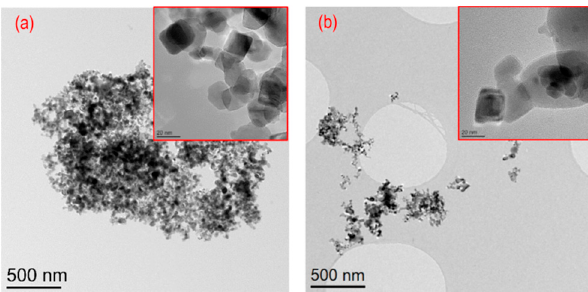
Figure 1. TEM images of ( a ) TiO 2 and ( b ) Ti(SO 4 )O (Copyright of Elsevier, see [15]).